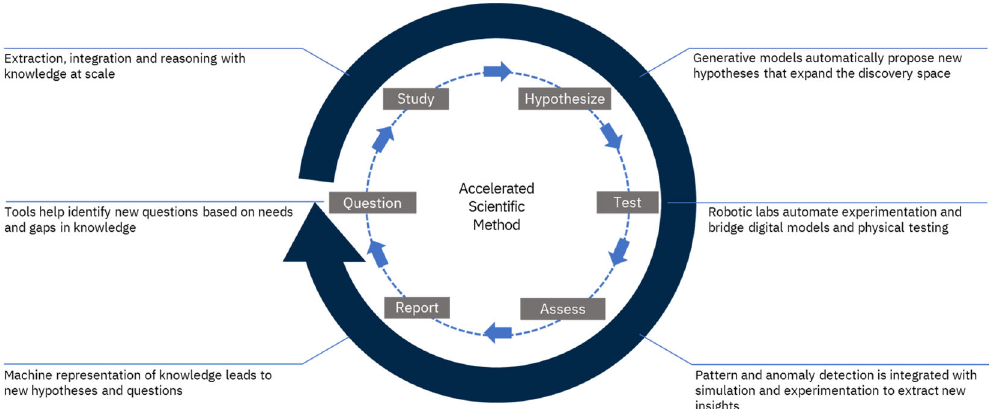
Fig. 2 Technology-driven acceleration of the discovery cycle. AI, HPC and robotic automation are helping to accelerate and enrich all stages of the discovery cycle through the ability to further scale efforts through improved generation of, access to and reasoning on a wide variety of